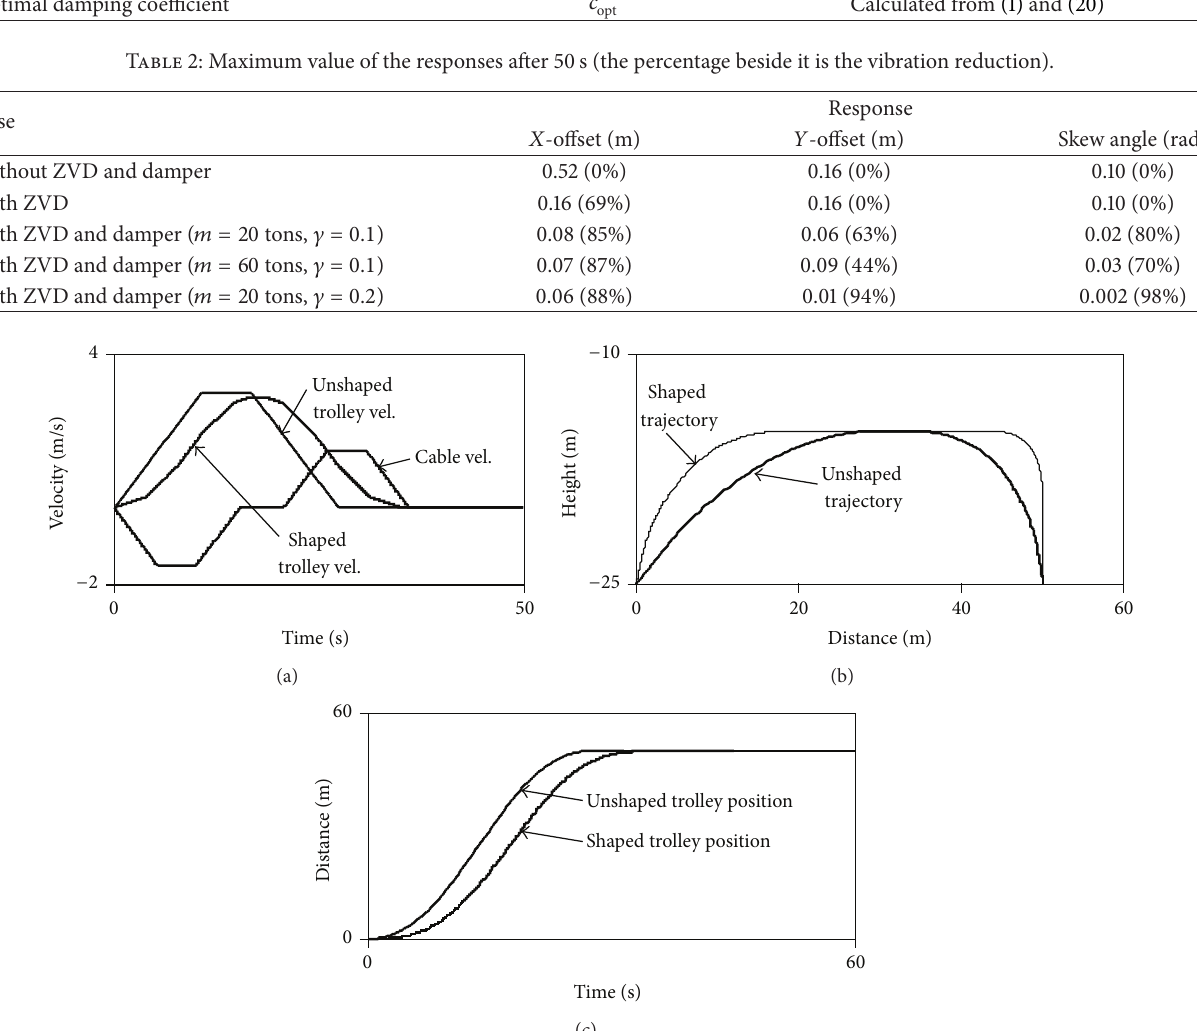
Figure 3: (a) The predefined velocity, (b) the predefined trajectory, (c) and the predefined trolley